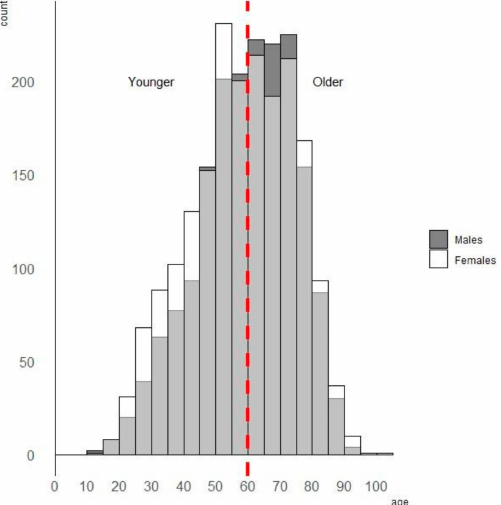
Figure 2. Histogram of cutaneous MM numbers in age groups of